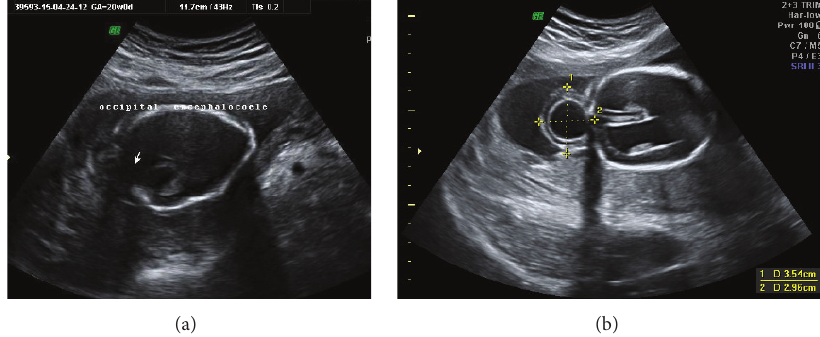
Figure 1: Occipital encephalocoele diagnosed at 20 weeks which was